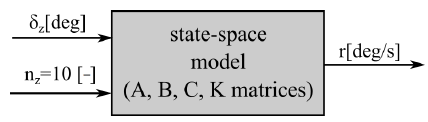
Figure 2. Linear model structure